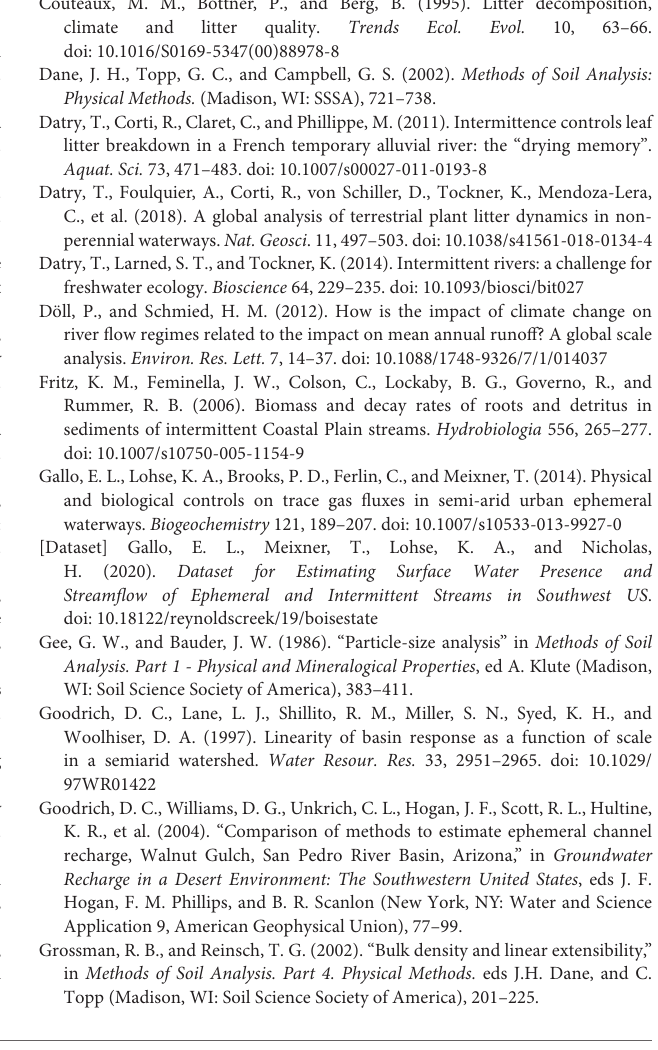
Supplementary Figure 1 | Cumulative precipitation dry-ephemeral [DE] sites (BG, SW, HP, GP), wet-ephemeral (WE) sites (RP, RL), dry-intermittent (DI) sites, (HU, GL), wetintermittent sites (WE) (HL, GU), and seasonally-intermittent (SI) sites (RU) locations since time of litterbag